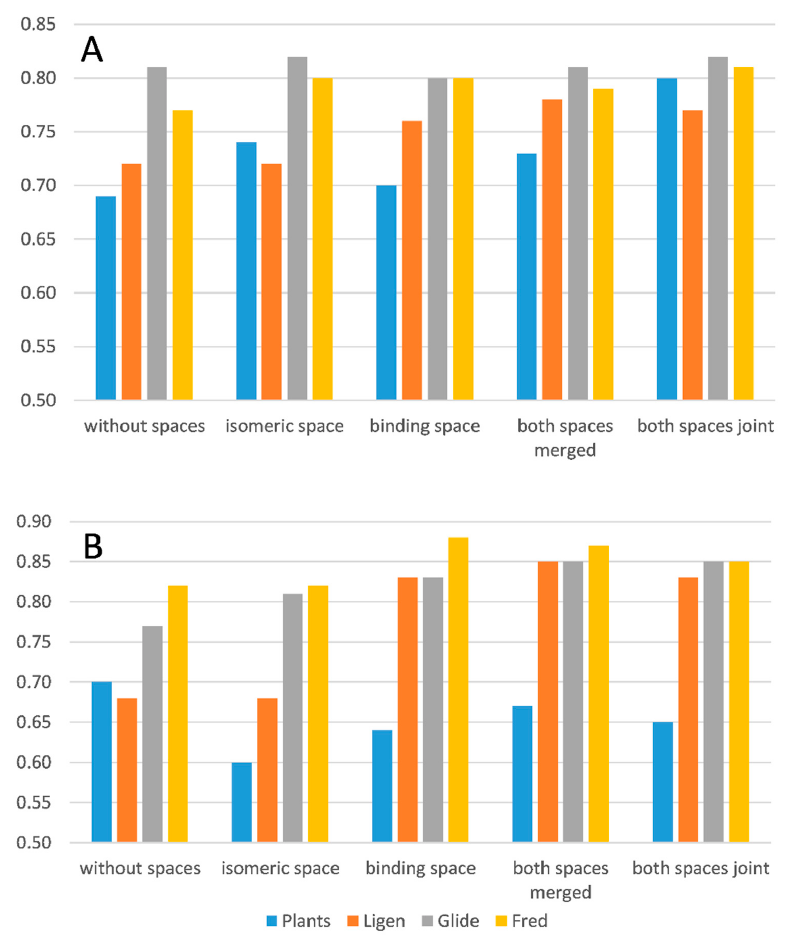
Figure 1. Comparison of the AUC values from the ROC curves for the best performing models gen- erated by the four utilized docking programs in the five tested conditions with ( A ) pIC50 > 5 and ( B ) pIC50 > 6. ( A ) pIC50 > 5 and ( B ) pIC50 >